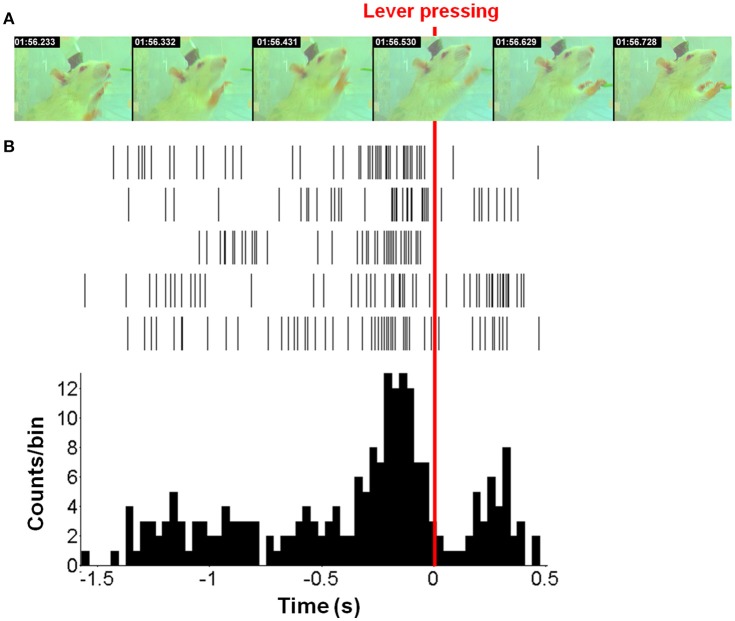
One example of forelimb movement over time. (A) The movement video of forelimb movement. (B) The neuronal activities were recorded from five neurons during one movement displayed as spike trains and the neuronal activity histogram (a bin size of 33 ms). The red line indicated the moment when the rat presses down the lever with the right-forelimb. Moreover, our results showed that neuronal firing rates highly correlated with forelimb movement; >71% (41/57) neurons exhibited specific firing changes during movement used to discriminate directional pairs.